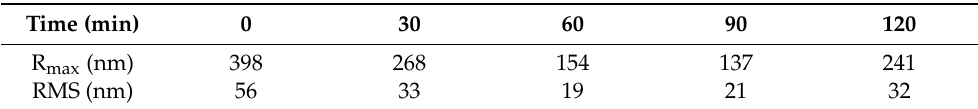
Table 1. The R max and Rms roughness of perovskite films prepared with various delayed anneal- ing